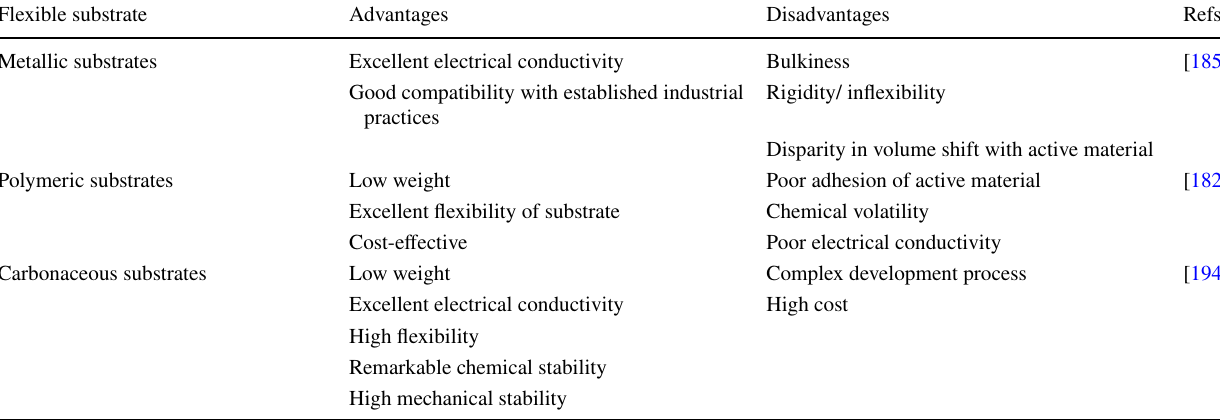
Table 3 Characteristic of metallic, polymer and carbonaceous substrates Flexible substrate Advantages Metallic substrates